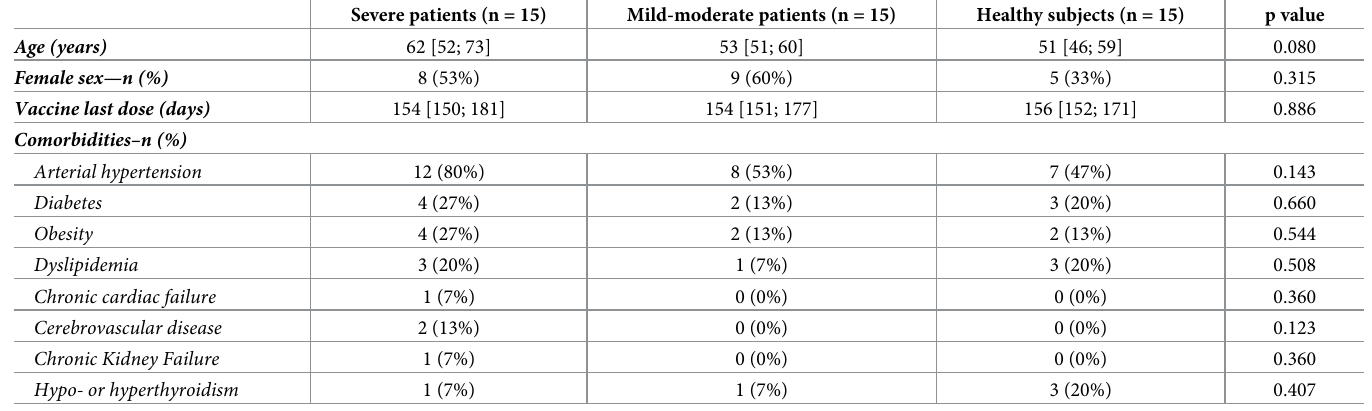
Table 1. Population